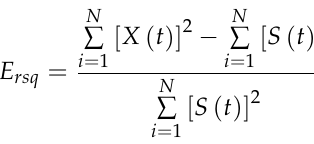
Figure 15. Relative amplitude plotted against the variable frequency of an input sine wave. The signal generator output amplitude was 500 mV, the frequency range was 500 kHz to 1 MHz, the step frequency was 20 kHz, and the attenuator decreased the signal by 110 dB. The theoretical gain of the digital lock-in amplifier was about 96.211 dB.